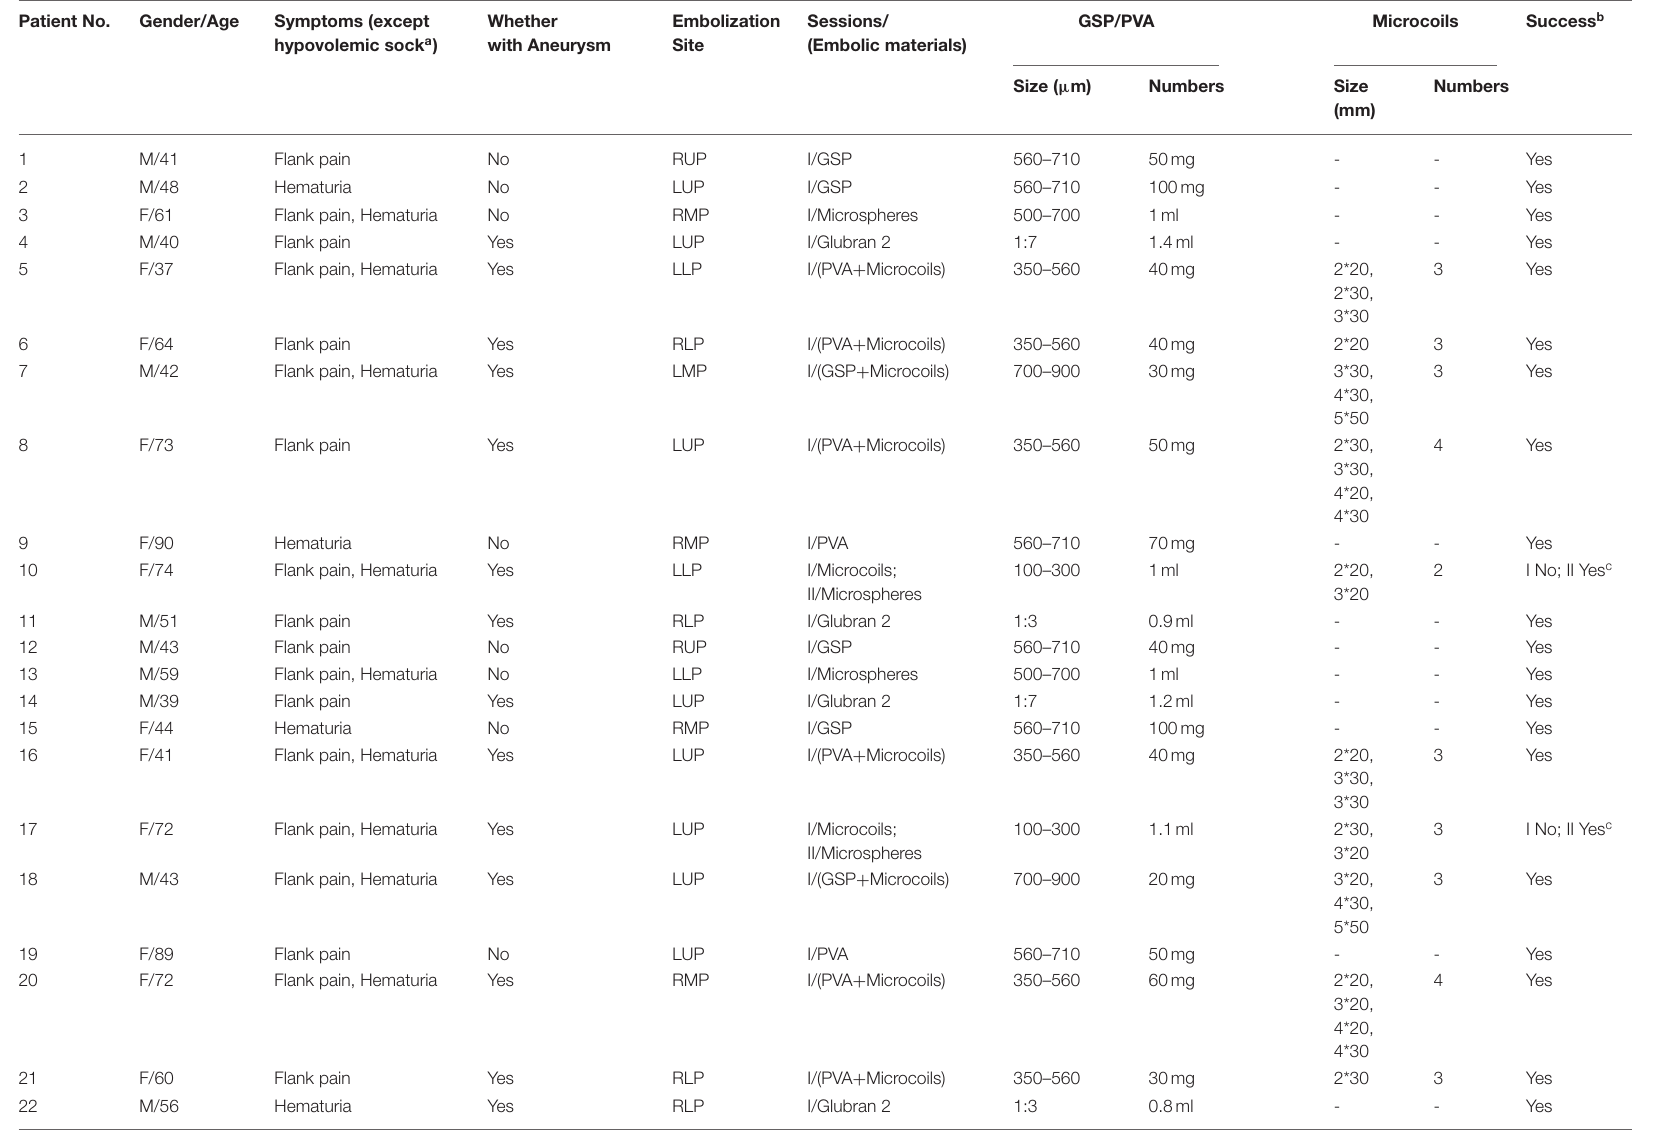
TABLE 1 | Patients underwent TAE with different materials for Wunderlich syndrome (WS) with hypovolemic shock secondary to ruptured renal AML. Patient